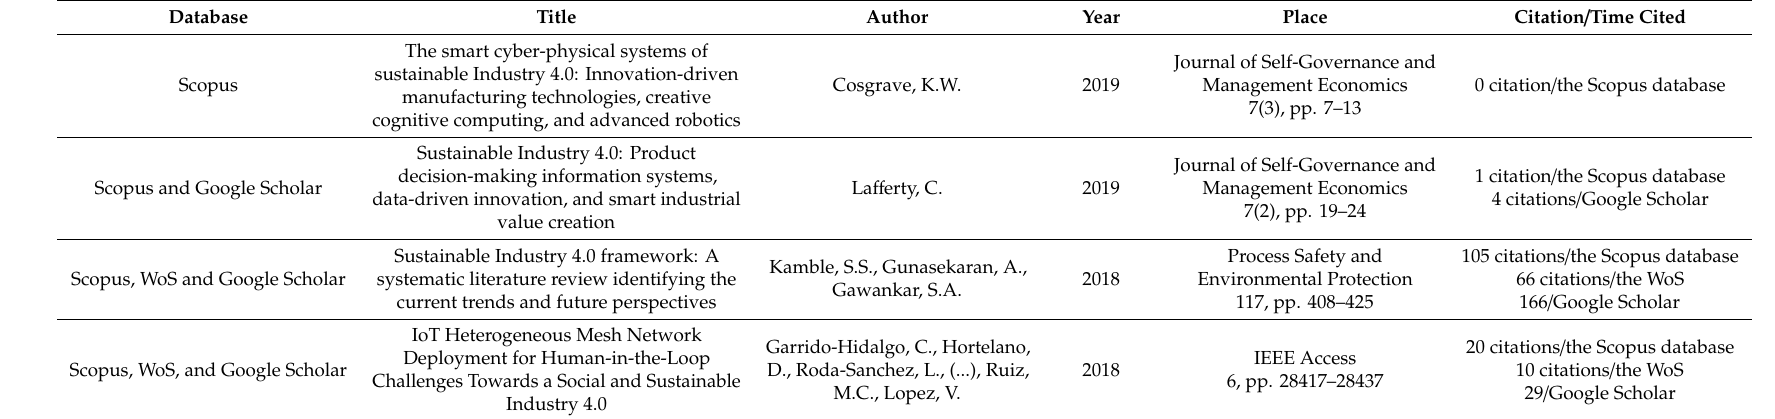
Table 10. Authors and papers in the subject: “Sustainable Industry